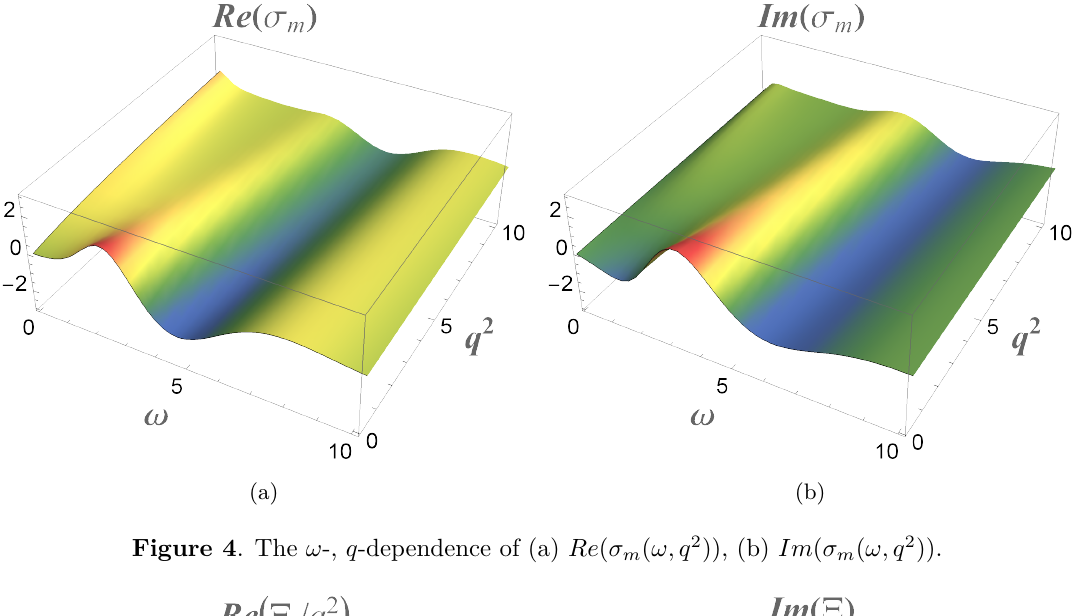
Figure 4 . The ω -, q -dependence of (a) Re ( σ m ( ω, q 2 )) , (b) Im ( σ m ( ω, q 2 )) .